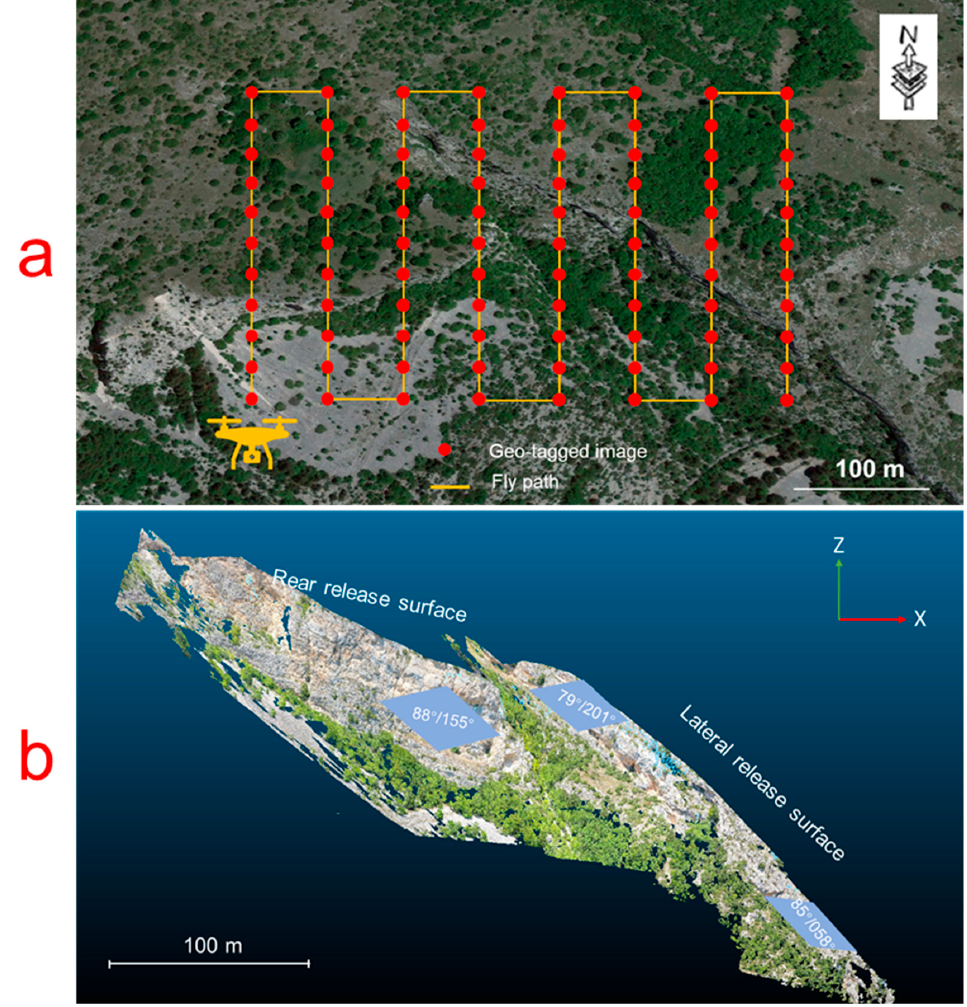
Figure 9. UAV photogrammetry, ( a ) UAV flight plan over the upper right corner of the failure zone, ( b ) point cloud showing the topography of the upper right escarpment of the landslide zone with highlighted 3 discontinuities that define the rear and lateral release surfaces.